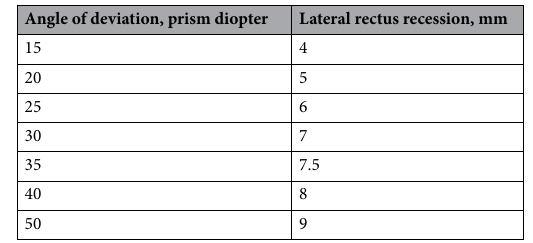
Table 1. Surgical amount in patients who underwent bilateral rectus recession.